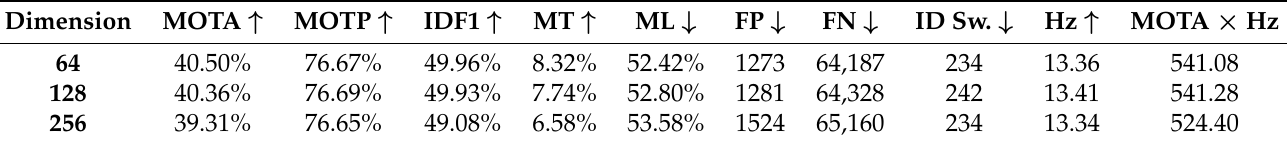
Table 4. Comparison of appearance models trained with different feature dimensions.